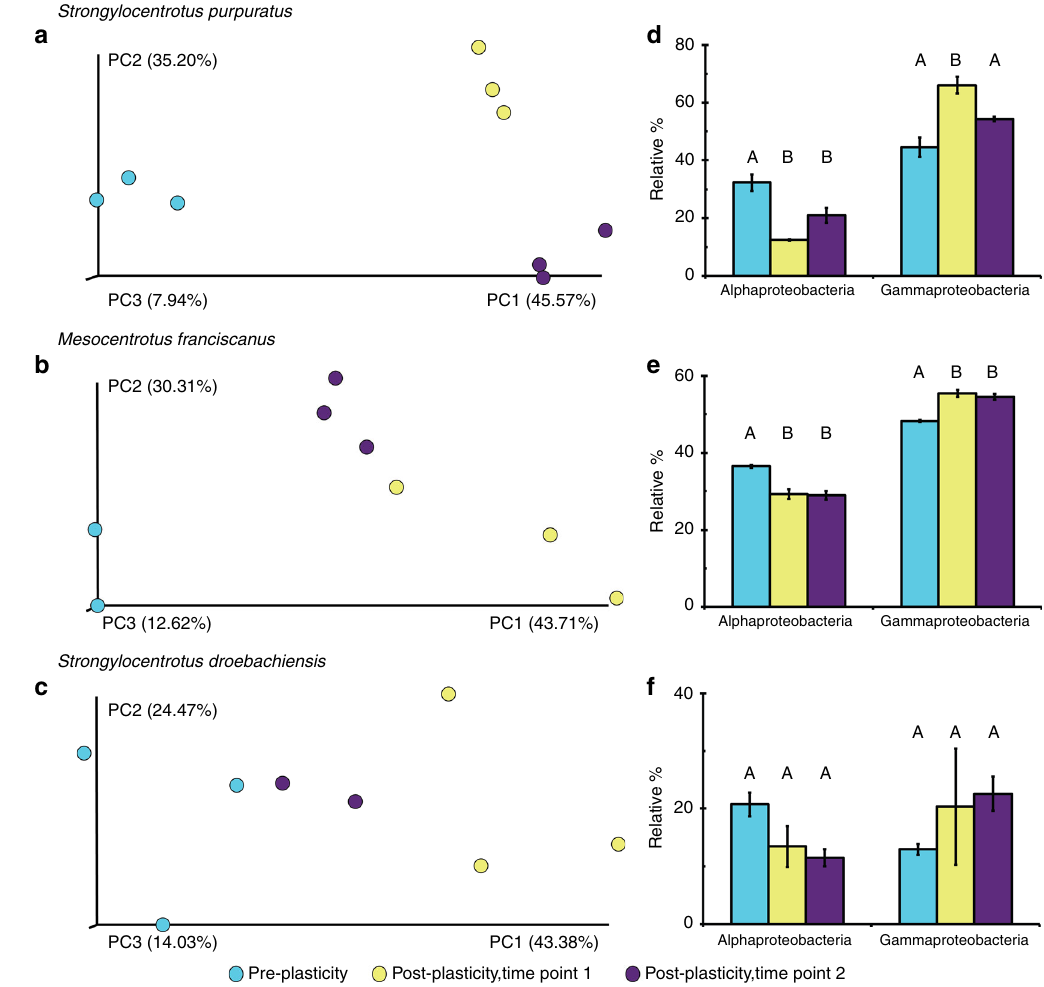
Fig. 2 Similarity of the associated microbial community along a phenotypic continuum for three species of echinoid larvae. Community similarity of the associated microbiota for Strongylocentrotus purpuratus ( a ), Mesocentrotus franciscanus ( b ), and S. droebachiensis ( c ) prior to (blue) and post (purple and yellow) expression of phenotypic plasticity. Along this continuum, larvae differentially associate with α - and γ -proteobacteria pre- and post-expression of phenotypic plasticity, respectively ( d S. purpuratus ; e M. franciscanus ; f S. droebachiensis